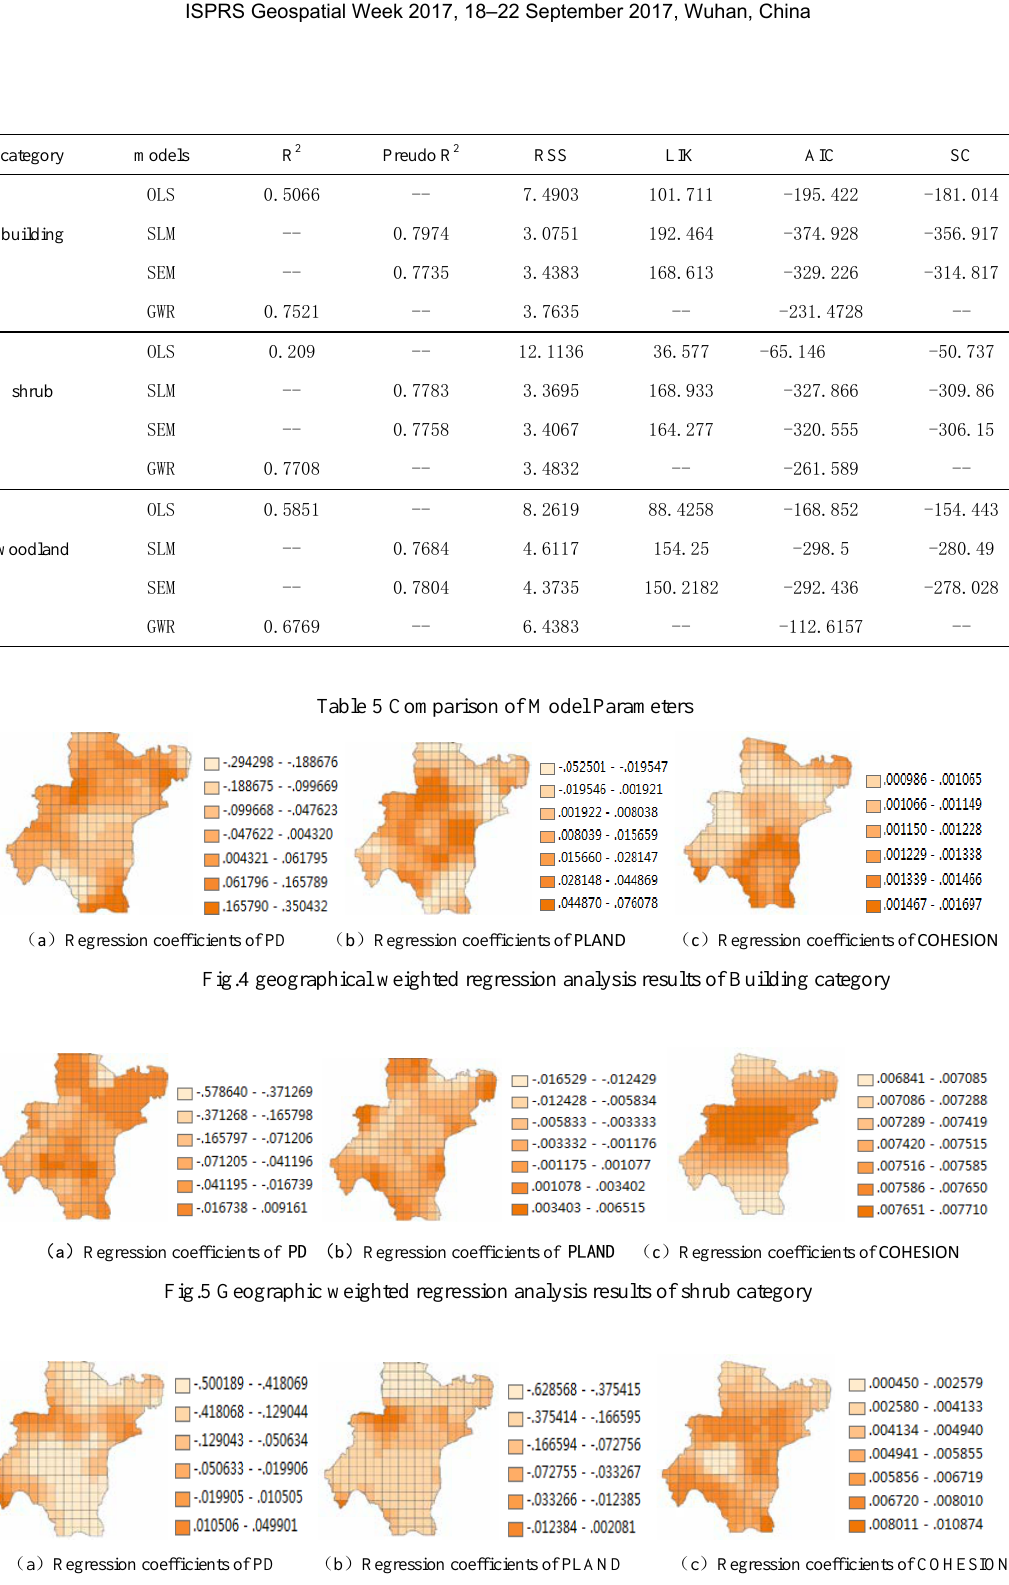
Fig.6 Geographic weighted regression analysis results of forest